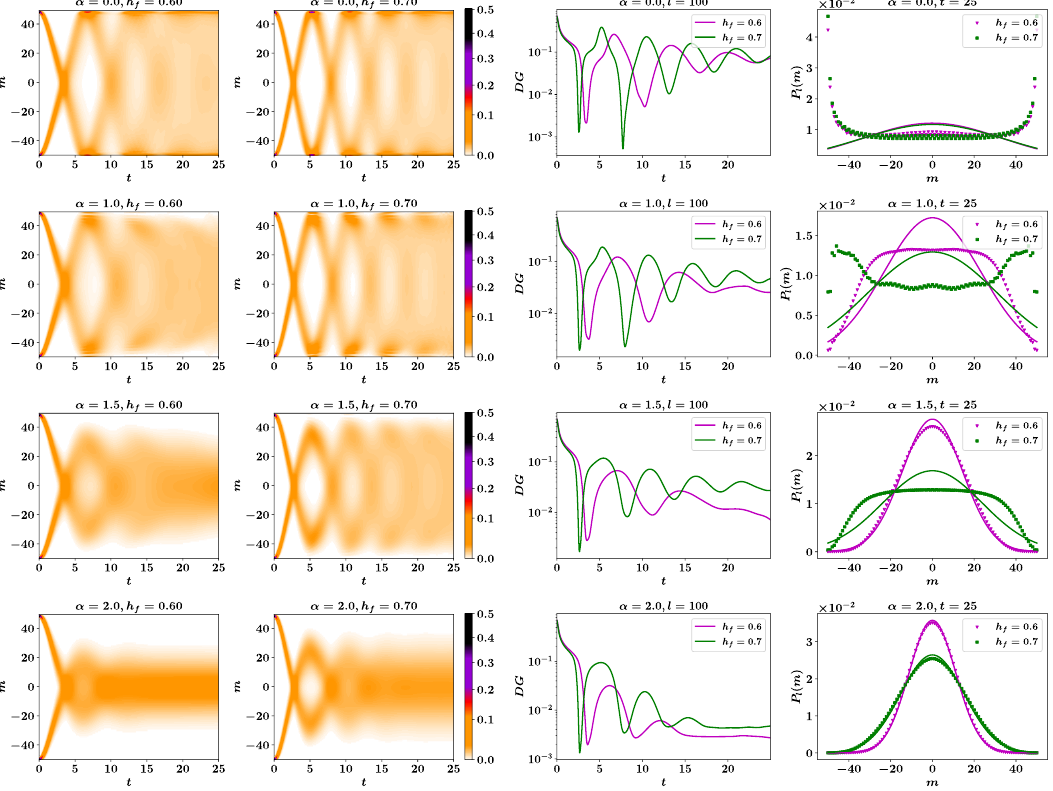
Figure 4: PDF of subsystem magnetization after a quantum quench for l = 100, α ∈ { 0.0,1.0,1.5,2.0 } and h ∈ { 0.60,0.70 } . The first two columns shows the evo- f lution of the PDF as a function of time t ∈ [ 0,25 ] . The third column shows the time evolution of DG (y-axis in log scale) and the last column shows the late time PDF at time t = 25 for the mentioned parameters. The symbols are the TDVP results whereas the corresponding full lines are the Gaussian approximation